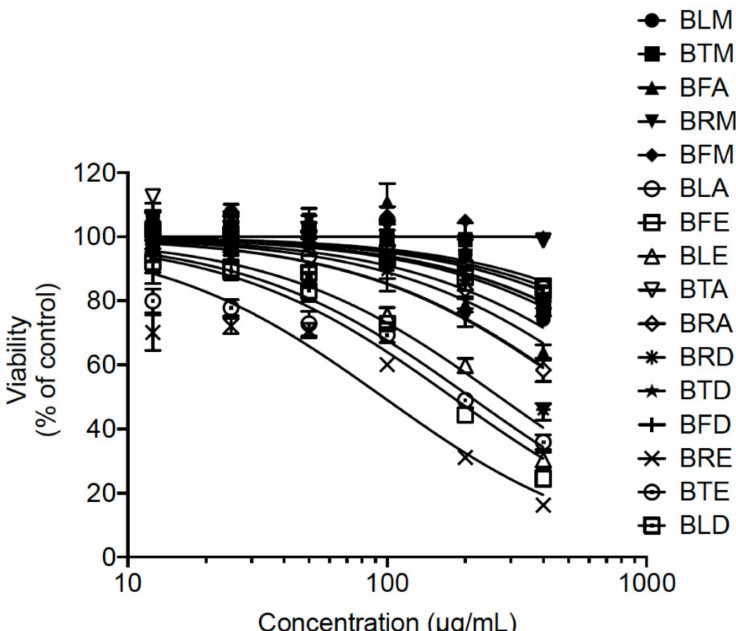
Figure 1. Cytotoxicity of B. gymnorhiza extract on A549 cell lines. A549 cells were incubated with different concentrations of B. gymnorhiza extract for 48 h. Cell viability was determined using the metabolic activity by MTT assays. Results are given as means ± SEM of four independent experiments and expressed as relative values in contrast to untreated cells.